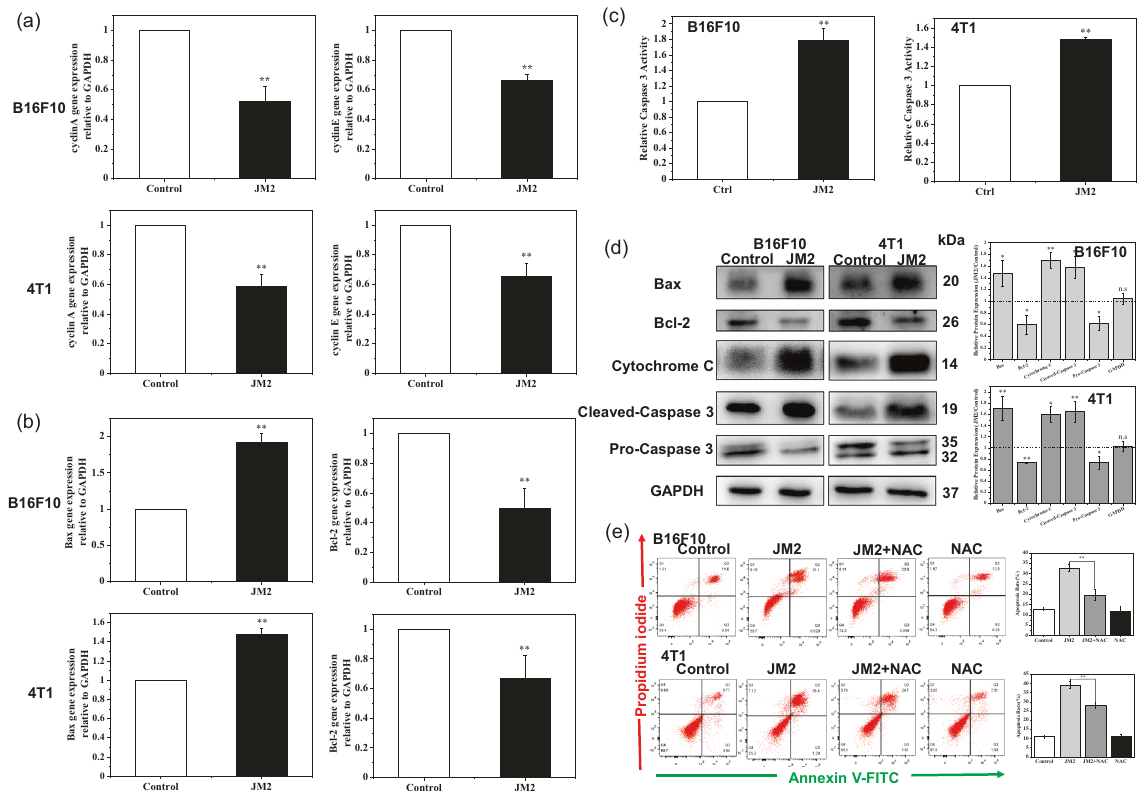
Fig. 6 JM2 regulated the expression of genes and proteins related to cell cycle and apoptosis. a Q-RT-PCR analysis of cyclin A and cyclin E mRNA in B16F10 and 4T1 cells. b Q-RT-PCR analysis of Bax and Bcl-2 mRNA in B16F10 and 4T1 cells. c Caspase 3 activity analysis of B16F10 and 4T1 cells cultured with JM2 solutions. d Expression of apoptosis-related proteins in B16F10 and 4T1 cells cultured with JM2 solutions. e Apoptotic effects and quantitative analysis of B16F10 and 4T1 cells cultured with different culture media. * p < 0.05 and ** p < 0.01 when the data was compared with the Control group. decreased as compared to that of cells cultured with normal culture medium. It can be seen from the above results that JM2 upregulated the gene expression of the pro-apoptotic protein Bax but downregulated the gene expression of the anti-apoptotic protein Bcl-2 in B16F10 and 4T1 cells. Then, the relative activity of Caspase 3 was calculated and the results are shown in Fig. 6c. After the cells were incubated with JM2 solution, the Caspase 3 activity of B16F10 and 4T1 cells increased. Moreover, the expressions of the mitochondrial apoptosis- related proteins were signi fi cantly changed in B16F10 and 4T1 cells after JM2 treatment. As displayed in Fig. 6d, the expression of pro-apoptotic protein Bax increased in the B16F10 and 4T1 cells treated with JM2 as compared to that in the cells cultured with normal medium. In contrast, the expression of anti-apoptotic protein Bcl-2 decreased in the B16F10 and 4T1 cells treated with JM2 as compared to that in the cells cultured with normal medium. In addition, cytochrome C released into the cytoplasm was increased in B16F10 and 4T1 cells treated with JM2. Additionally, Cleaved-Caspase 3 protein was highly expressed in B16F10 and 4T1 cells after JM2 treatment. Thus, after tumor cells were incubated with JM2 solution, the activated Caspase 3 that mediated apoptosis in the cells increased. Correspondingly, the protein of inactive Pro-Caspase 3 in the cell was reduced. We found that the expression of Pro-Caspase 3 protein in B16F10 and 4T1 cells treated with JM2 was decreased than that in the cells cultured with normal culture medium.The raw data of western blot results were shown in supplementary material.